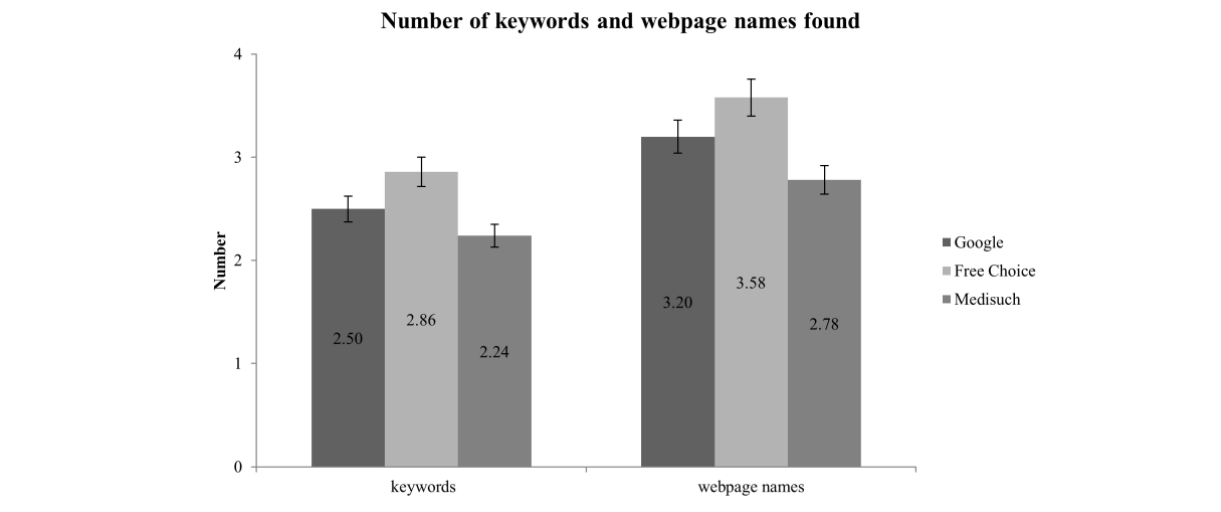
Figure 3. Number of keywords and webpage names found by students for each group.